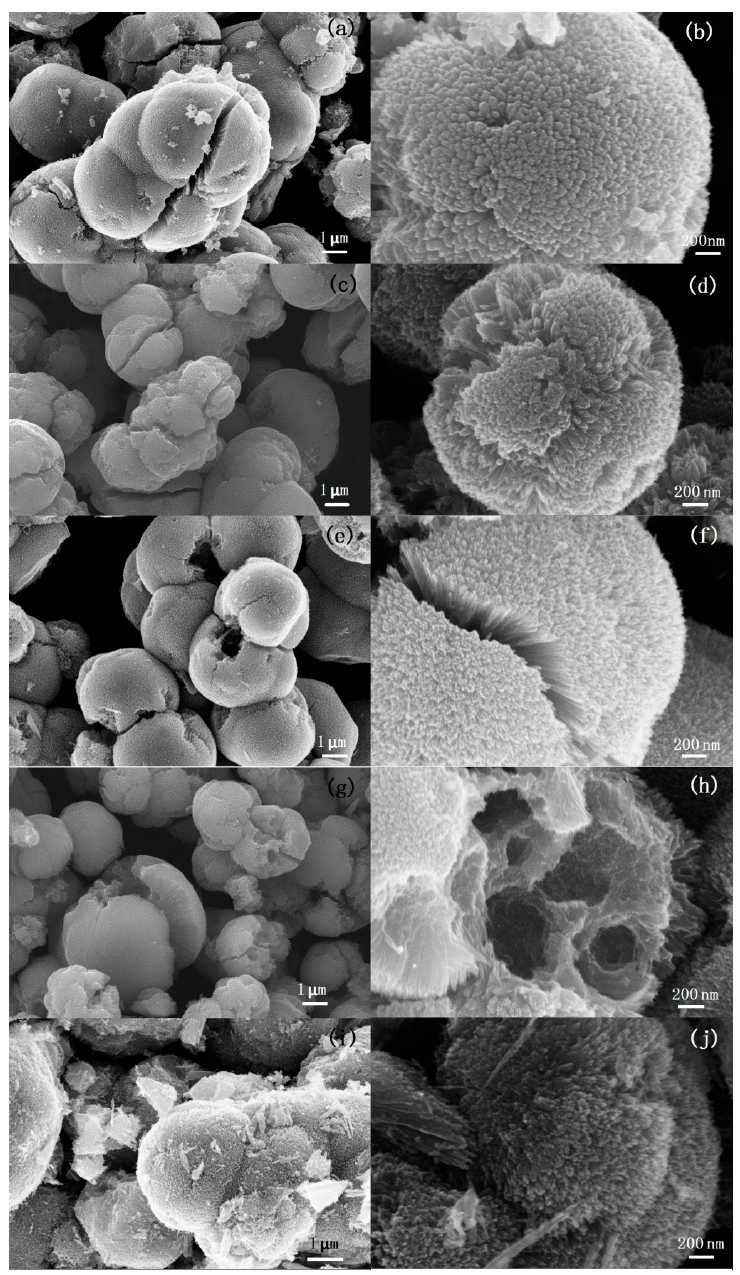
Figure 3. SEM images of the TiO 2 samples synthesized at 135 ◦ C under ( a , b ) 1 min, ( c , d ) 5 min, ( e , f ) 10 min, ( g , h ) 20 min, and ( i , j ) 30 min microwave